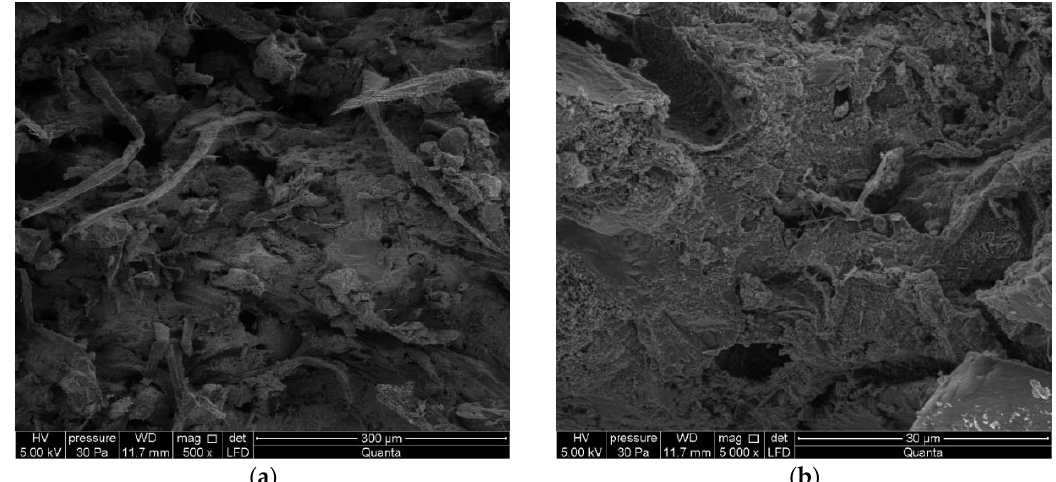
Figure 13. SEM images under magnification 500 × ( a ) and 5000 × ( b ) for board D after 24 h of storage in water.